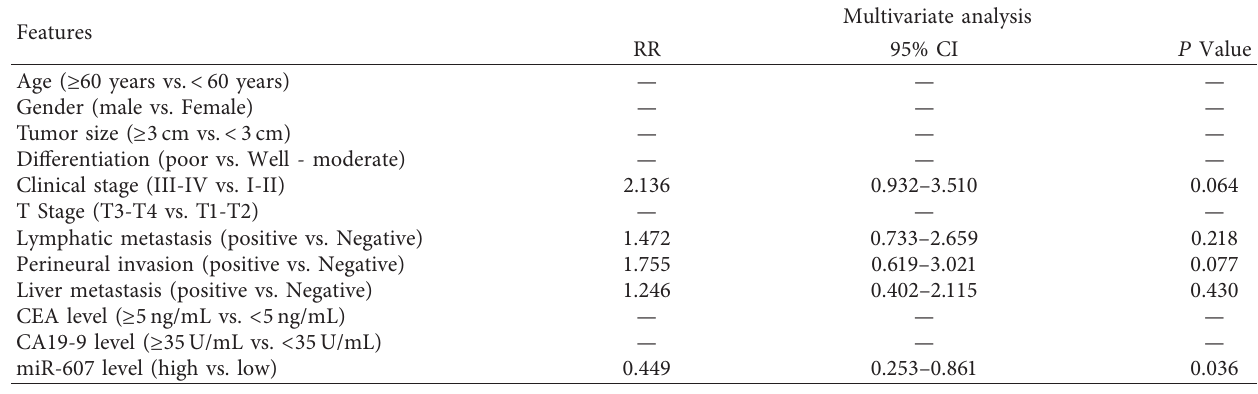
Table 3: Multivariate Cox regression analysis of different prognostic factors for OS in PDAC